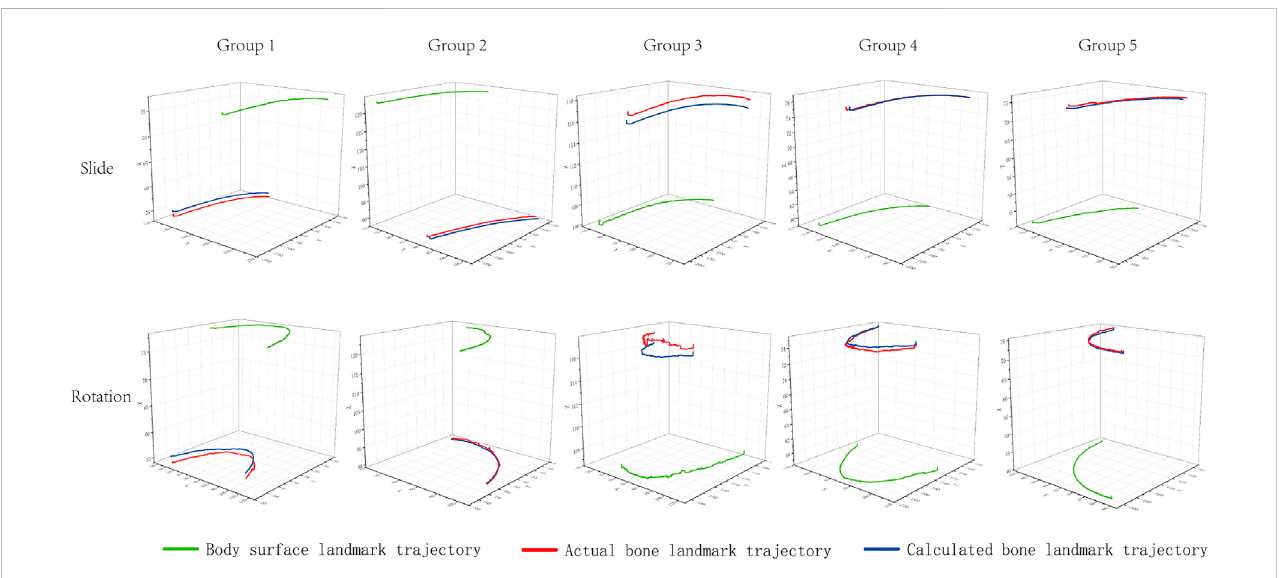
FIGURE 3 Measured trajectories of bone and body surface landmarks and calculated trajectories of bone landmarks. The green line is the actual trajectory of the simulated body surface landmark measured by motion capture. The red line is the actual trajectory of the simulated bone landmark measured by motion capture. The blue line is the trajectory of the bone landmark calculated by the novel in vivo